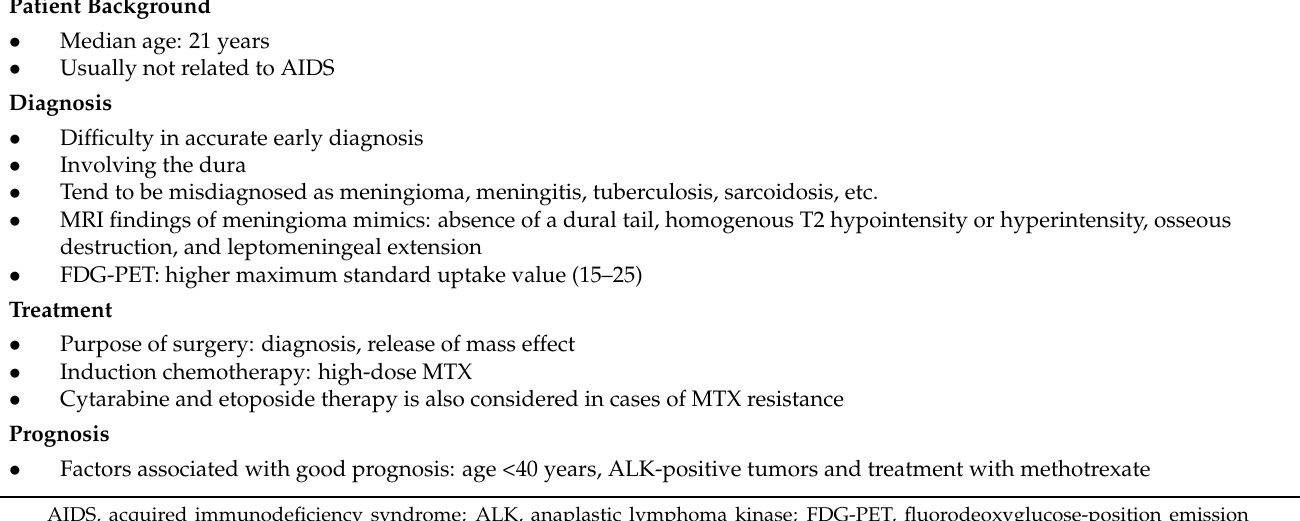
Table 5. Summary of clinically important features for primary anaplastic large cell lymphoma of the central nervous system. Patient